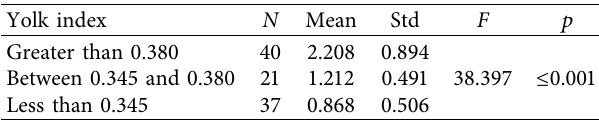
Table 4: Results of analysis of variance for the ovomucin con- centration at various yolk index values.